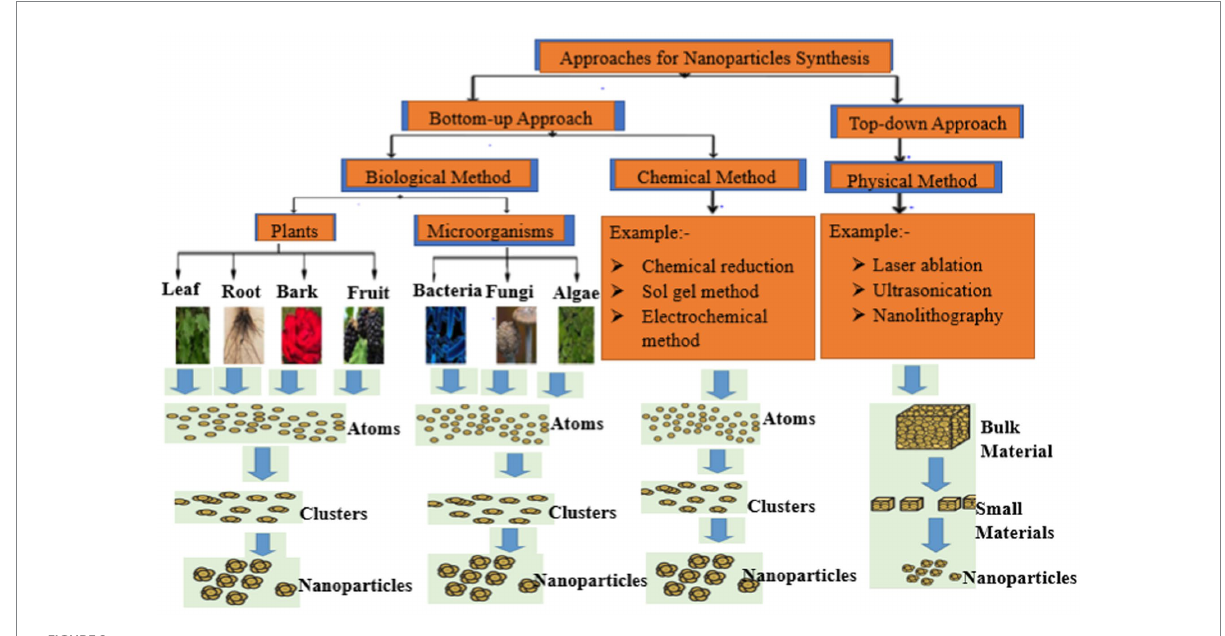
FIGURE 2 Overview of the methods used for nanoparticles